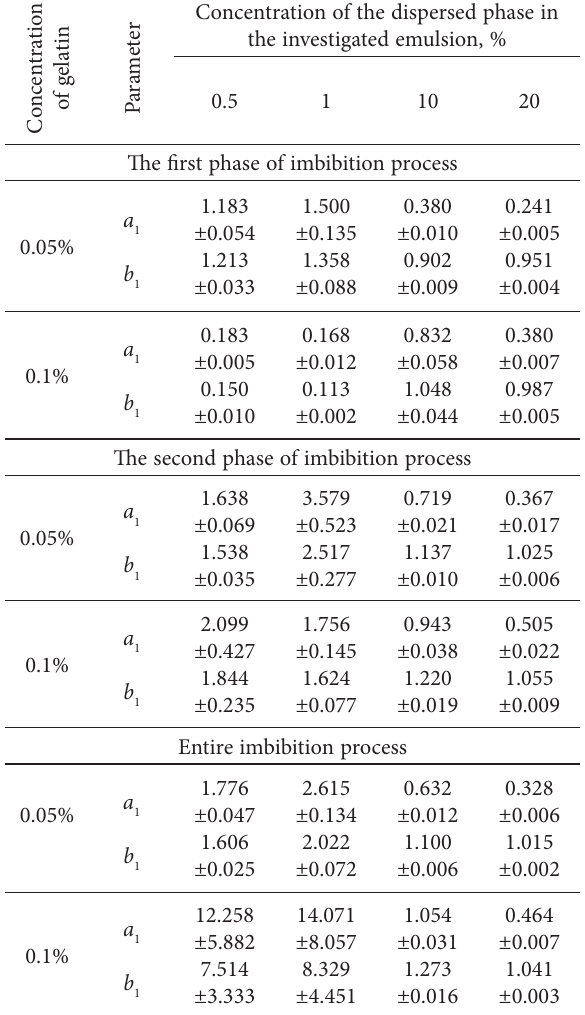
Table 2. Parameters for the classic Lucas–Washburn equation Table 3. Parameters for the modified Washburn